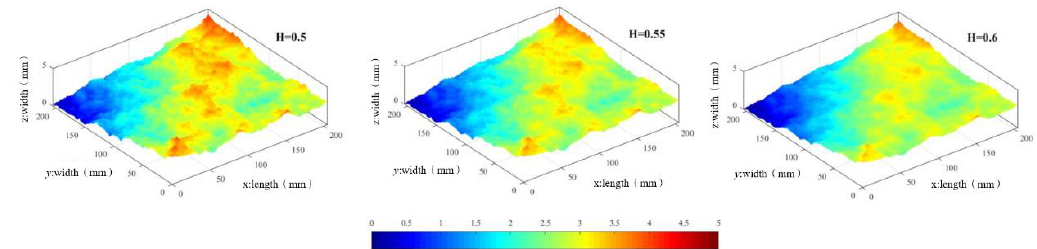
Figure 1. Generated rough fracture surface.